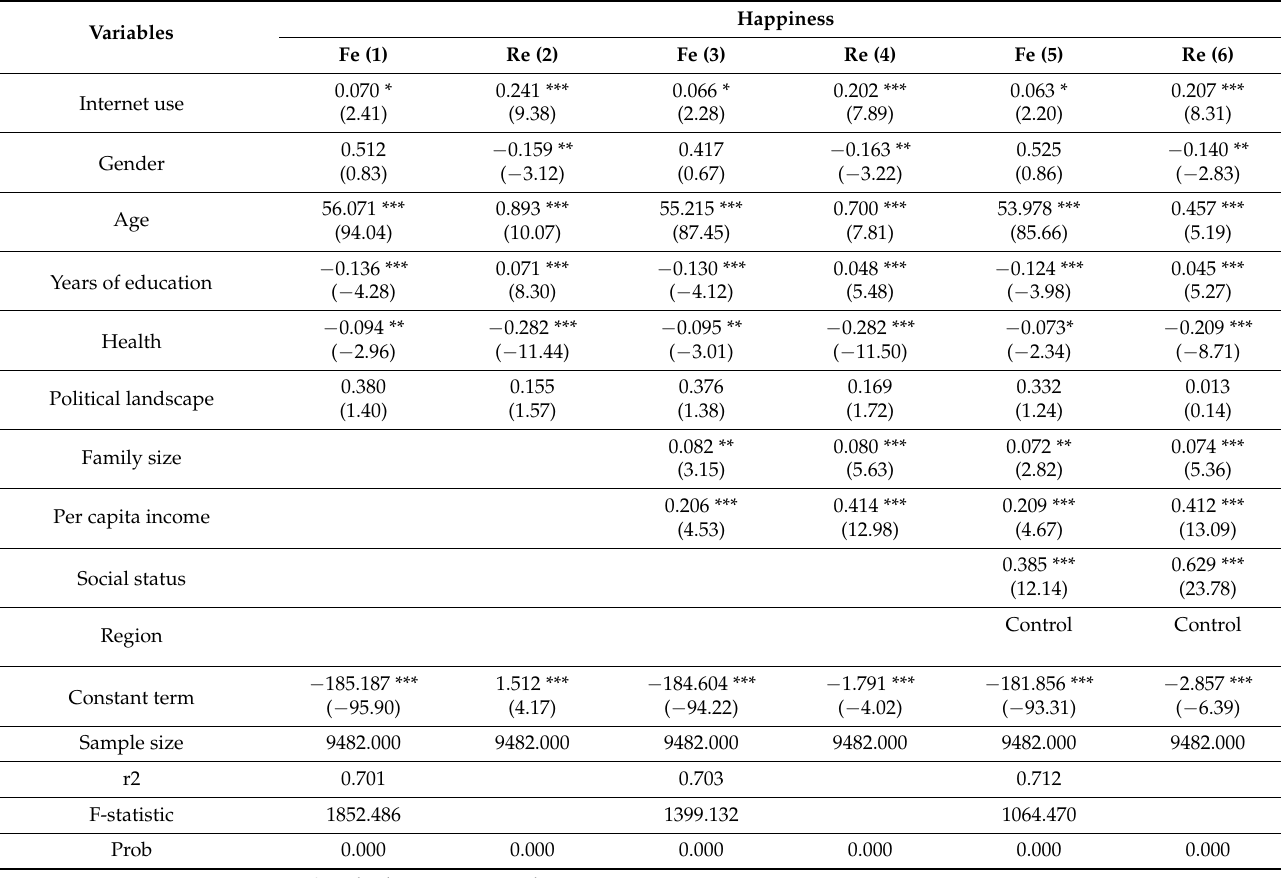
Table 2. Analysis of the impact of Internet use on rural residents’